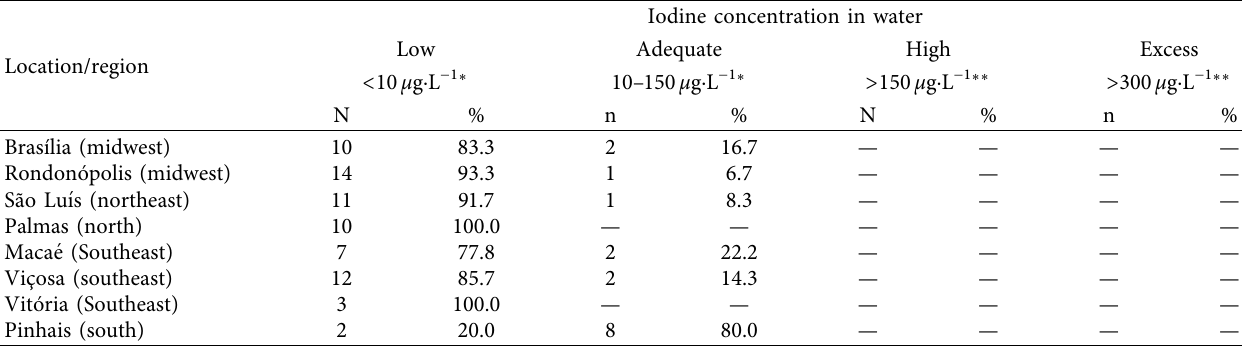
Table 3: Median, minimum, and maximum iodine concentrations in water samples from Primary Healthcare Units (PHUs) in mac- roregions of Brazil. Drinking